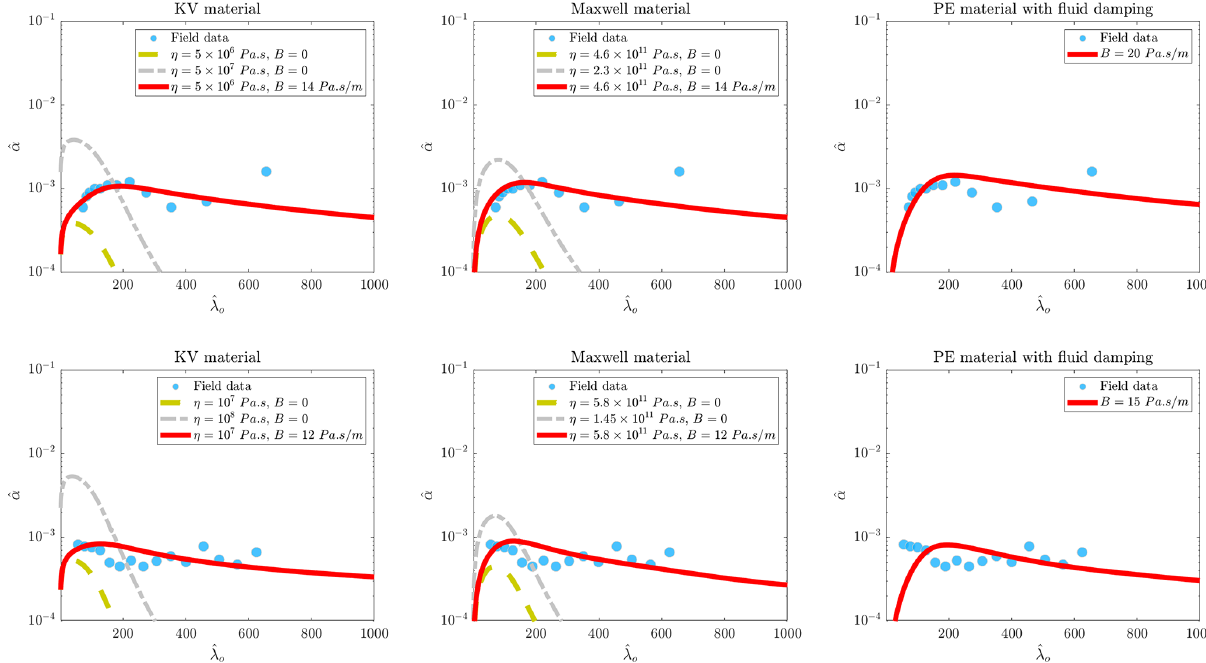
Figure 7. Comparisons between ˆ α vs. ˆ λ o curves predicted by different models and the data measured by Wadhams et al. (1988), upper row, and Meylan et al. (2014), lower row. In the first and second columns, decay rates predicted by setting a zero fluid damping are also plotted. The shear modulus of ice is set to be